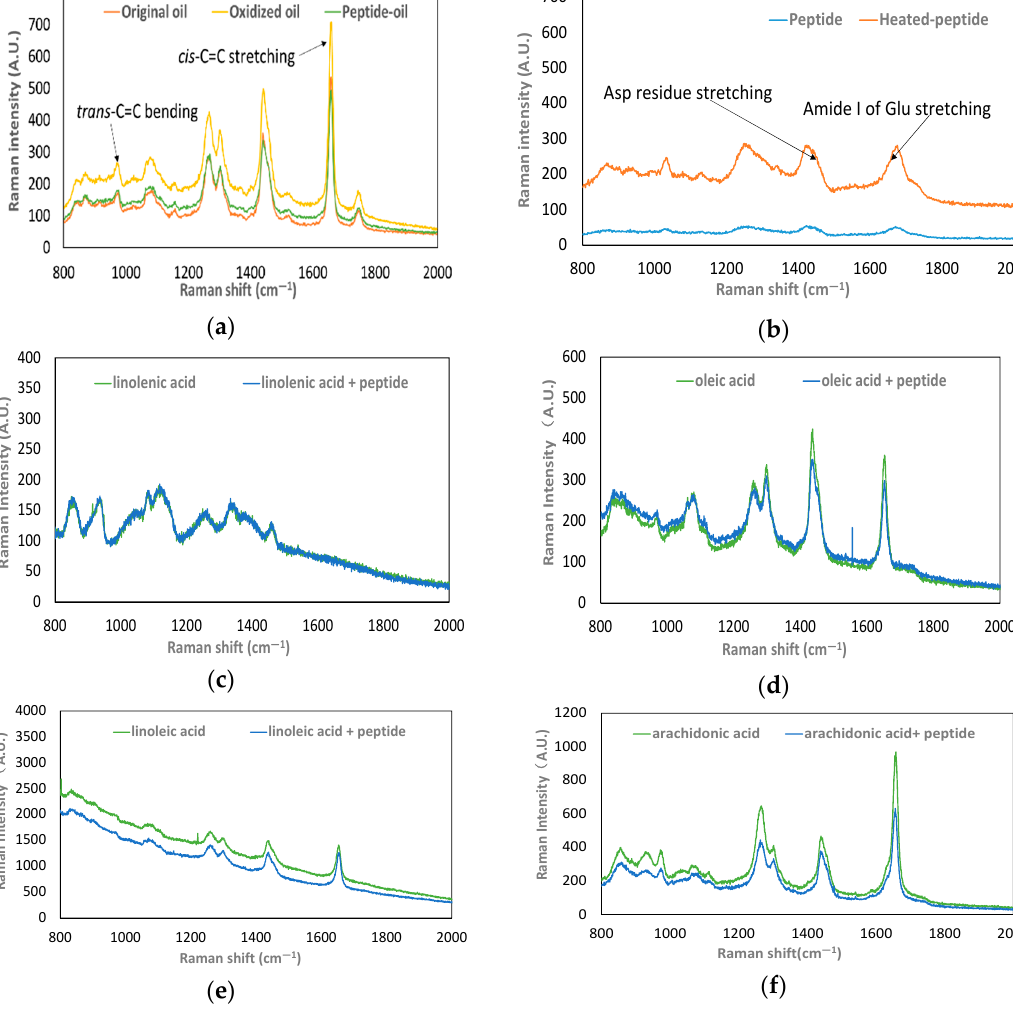
Figure 3. Raman spectra of lipid in the range from 800 cm − 1 to 2000 cm − 1 . ( a ) Raman spectra of un-oxidized walnut oil, oxidized walnut oil, and oxidized peptide–oil. ( b ) Raman spectra of the peptide and the heat-treated peptide. ( c ) Raman spectra of oxidized linolenic acid and oxidized linolenic acid with peptide. ( d ) Raman spectra of oxidized oleic acid and oxidized oleic acid with peptide. ( e ) Raman spectra of oxidized linoleic acid and oxidized linoleic acid with peptide. ( f ) Raman spectra of oxidized arachidonic acid and oxidized arachidonic acid with peptide.